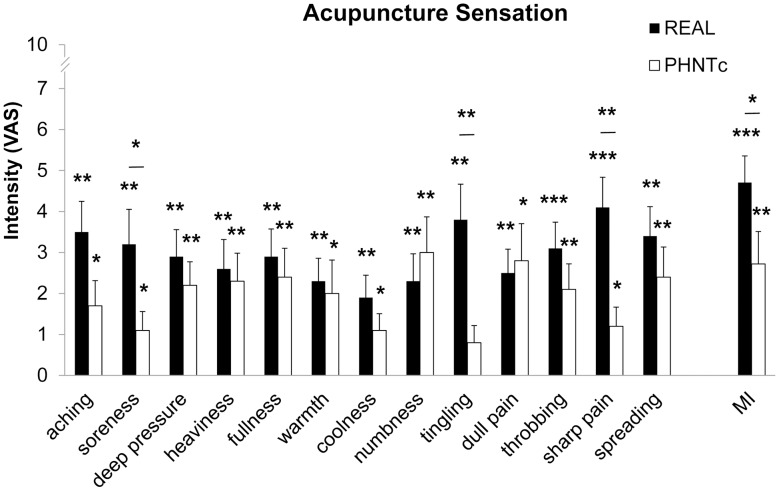
Influence of somatosensory needling on acupuncture sensations to real (REAL) and credible (PHNTc) phantom acupuncture.PHNTc reported similar sensation intensity as REAL for several deqi-related sensations (e.g., deep pressure, heaviness, fullness, numbness, dull pain). REAL produced greater sensation intensity for soreness, tingling, and sharp pain, as well as overall deqi sensation (i.e. MI). Comparisons between REAL and PHNTc were based on the data collected only from subjects who regarded phantom acupuncture as real (i.e. PHNTc) and was done using paired t-tests. n.b. *<0.05, **<0.01, ***<0.001. Error bars represent standard error of the mean.